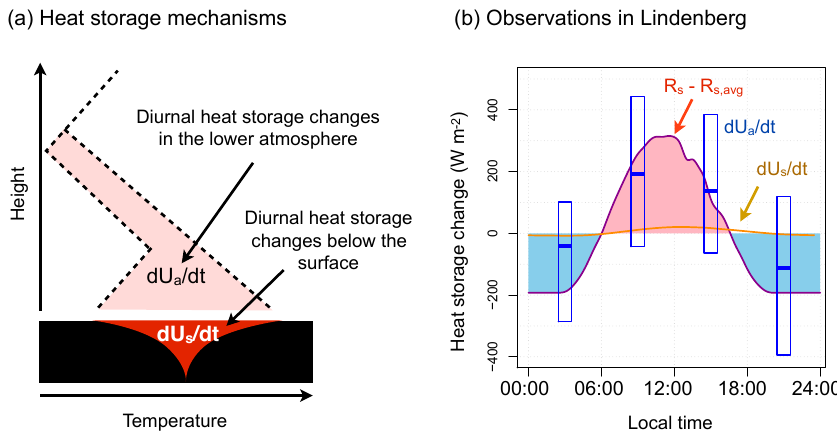
Figure 2. Diurnal changes in heat storage are reflected in variations of soil temperature near the surface and in variations of air temperature and humidity in the lower atmosphere. Panel (a) shows a schematic diagram of these heat storage changes. It shows a typical, colder nighttime profile with an inversion near the surface and a warmer daytime profile. The difference between the extremes of these temperature (and humidity) profiles (area shaded in light red) corresponds to the change in diurnal heat storage change in the lower atmosphere, d U a / d t . Typical changes in belowground temperature profiles are also shown, with the heat storage change d U s / d t being marked in dark red. Panel (b) shows observations from Lindenberg, Germany, for the mean diurnal variation of absorbed solar radiation (shifted by its mean), R s − R s , avg , averaged for the month of June over the years 2006–2009 (red line, n = 480), the diurnal variation in heat storage in the lower atmosphere derived from 6-hourly radio soundings, d U a / d t (blue boxes represent the interquartile range and the horizontal thick blue line the median) and the ground heat flux, d U s / d t (orange